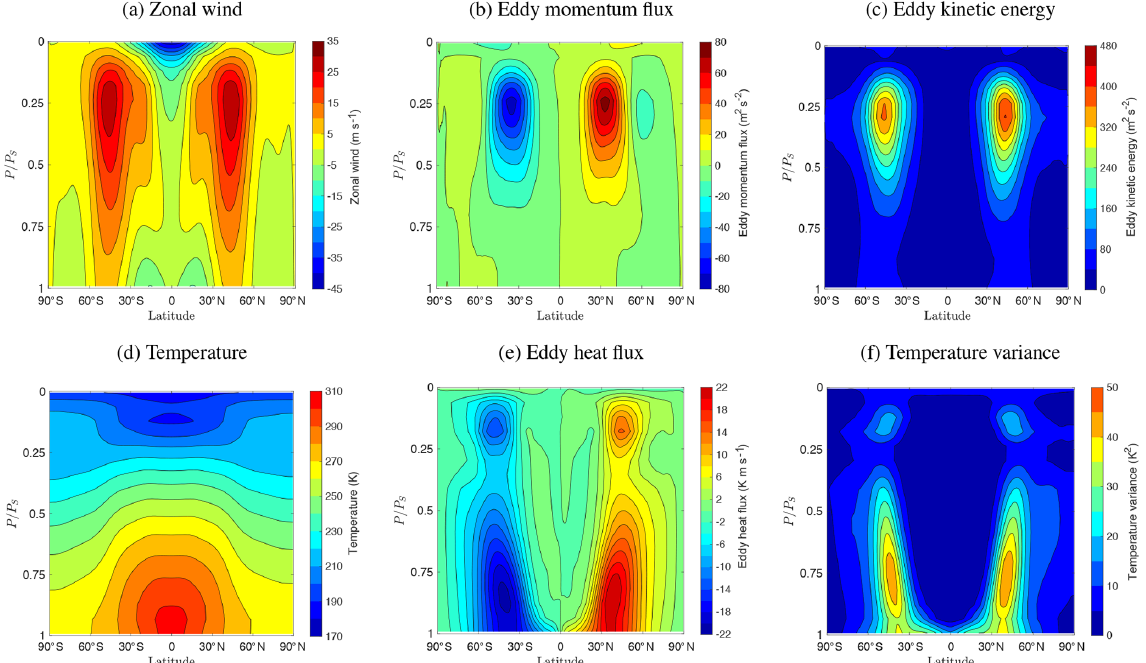
Figure 14. Time–zonal statistics for the high-resolution (Held and Suarez, 1994) test case with scales J = 6 , 7 , 8 (maximum resolution 1 / 4 ◦ ). The grid is adapted on the solution error with tolerance ε = 0 . 02. Statistics are averaged over 200 days after day 700 by interpolating saved data to the finest